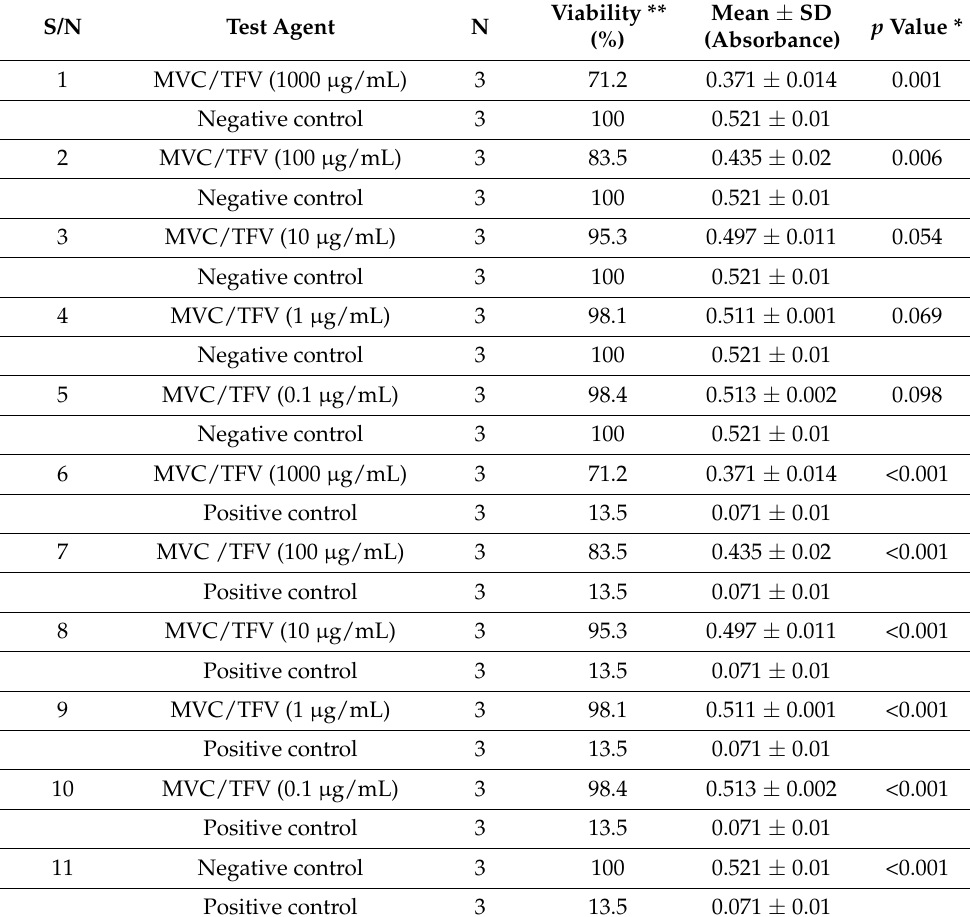
Table 8. Independent sample t -test, comparing the means of absorbance of the test agent and controls to test for significance in cytotoxicity